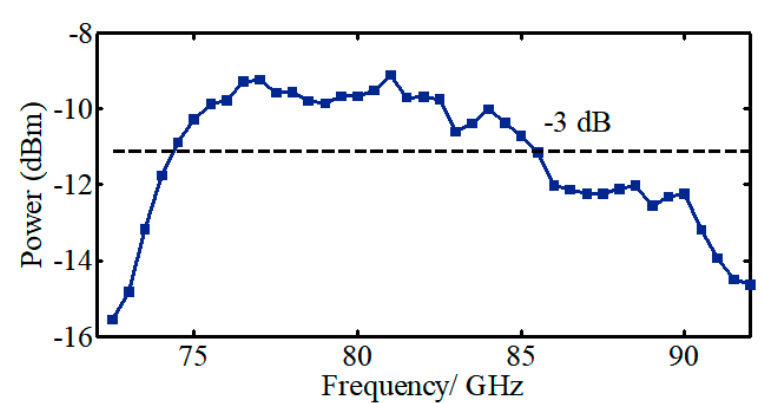
Figure 10. Detected power after the QO system.